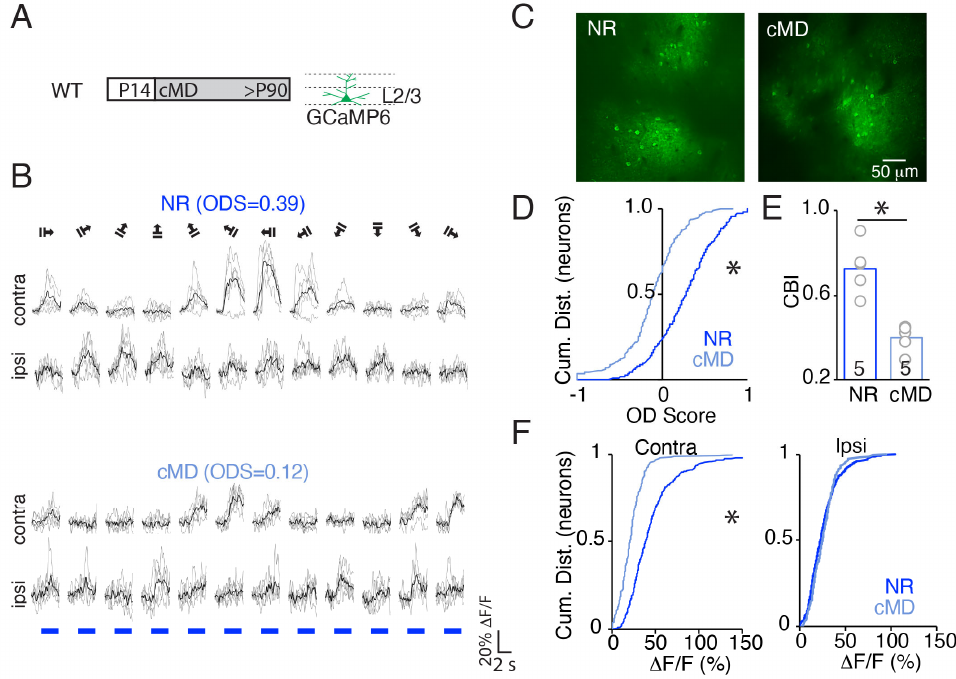
Figure 1. cMD decreases the strength of the deprived eye pathway in WT but not MMP9 − / − mice. ( A ) Left: Experimental timeline. MD was initiated at eye opening (postnatal day 14 (P14)) and maintained until adulthood (>P90). Right: GCaMP6s expression was targeted to layer 2/3 neurons of WT V1b (AAV1.hSyn1.mRuby2.GSG.P2A.GCaMP6s.WPRE.SV40, Addgene, titer: 1.3 × 10 13 U/mL, 30 nl, AP: 1.0 mm, MD: − 3.0 mm, DV: 0.3 mm; at least 3 weeks prior to imaging) to monitor visual evoked calcium transients. ( B ) Representative Δ F/F of the GCaMP6s signal evoked in layer 2/3 of V1b in normal reared (NR) and cMD WTs in response to the presentation of drifting square wave gratings (0.05 cycle/degree, 100% contrast, 28 cd/m 2 at 12 orientations) to contra ‐ and ipsilateral eyes. Blue bar = stimulus onset. Individual trials in grey, average of 5 repeats in black. Ocular dominance score (ODS) = (C ‐ I)/(C + I) was calculated at the preferred orientation for each neuron. ( C ) Examples of two ‐ photon field views of GCaMP6s expression. ( D ) Cumulative distribution of ODS. * p = 1.0 × 10 − 4 , KS test. ( E ) Mean CBI of layer 2/3 neurons is significantly lower in cMD than NR WT mice. * p = 0.012, Mann − Whitney test. n = 5 subjects. ( F ) Cumulative distribution of contra and ipsi eye neuronal responses ( Δ F/F; * p = 8.3 × 10 − 29 for contra, p = 0.91 for ipsi, Student’s t ‐ test, 365 and 201 neurons for NR and cMD, respectively).